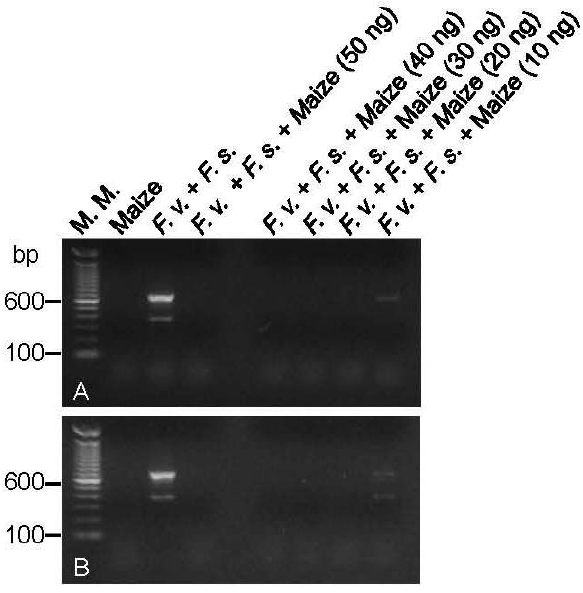
Figure 5. Multiplex PCR reactions for the simultaneous detection of F. verticillioides and F. subglutinans in the presence of maize DNA. The PCR reactions were performed with FV-F2/FV-R and FS-F1/FS-R primer pairs and the genomic DNA of maize (50 ng), of F. verticillioides together with F. subglutinans (0.5 ng of each in A and 5 ng of each in B) alone or with increasing amounts of maize DNA. M.M. indicates the 100-bp molecular marker from Invitrogen (USA). F. v. is Fusarium verticillioides CML 767. F. s. is F. subglutinans UnB